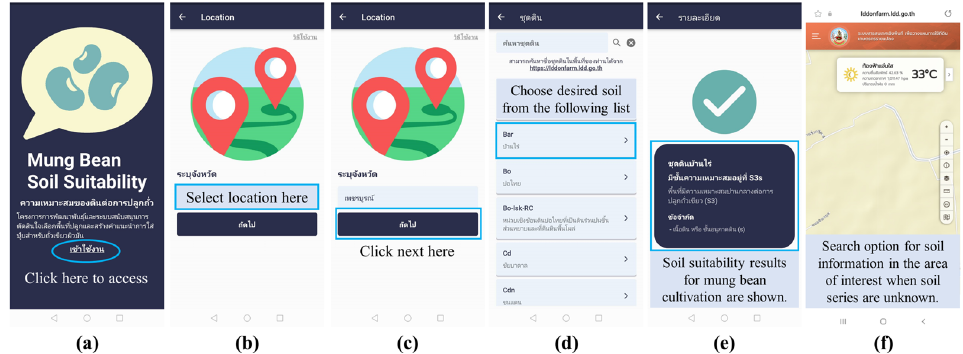
Figure 3. Windows and usage procedures of “Mung Bean Soil Suitability” mobile application. ( a )